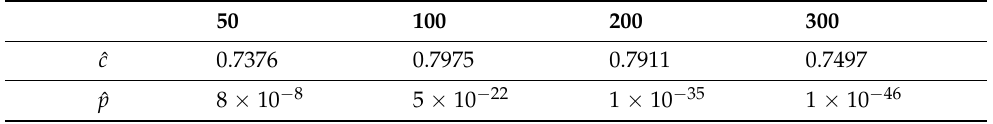
Table 8. ˆ c = Average Spearman’s Rank Correlation between the centrality measures: Pagerank versatility and corner centrality, across the multilayer networks with the same number of nodes. ˆ p = Average p -value ( p ) across the multilayer networks with the same number of